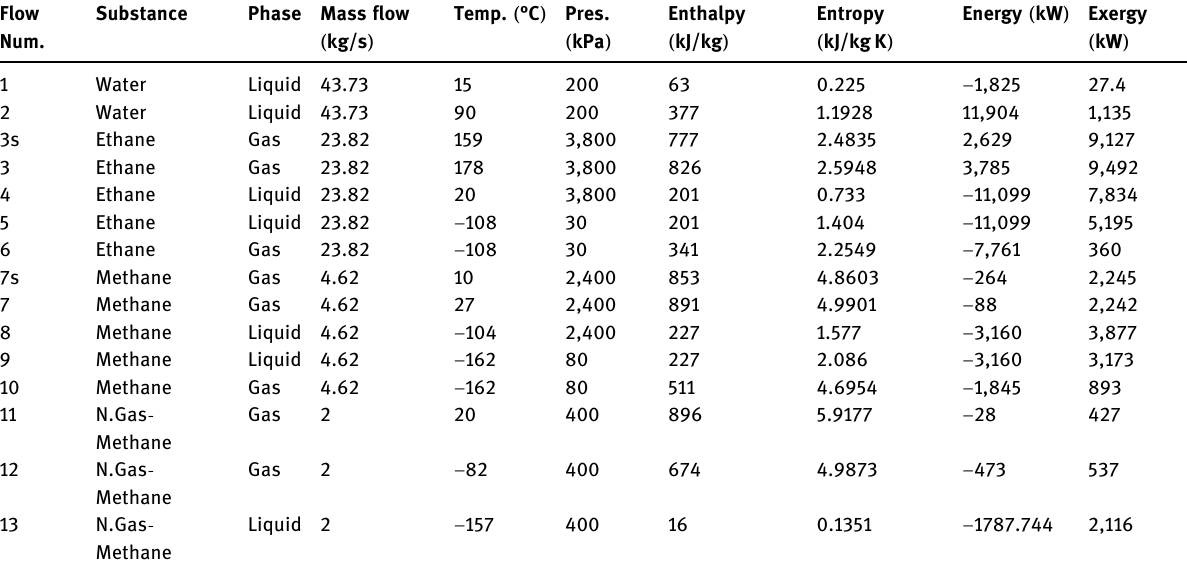
Table 6: Thermodynamic properties of fl ow lines for natural gas entering at 20°C and 400 kPa ( P 7 = 2,400 kPa )